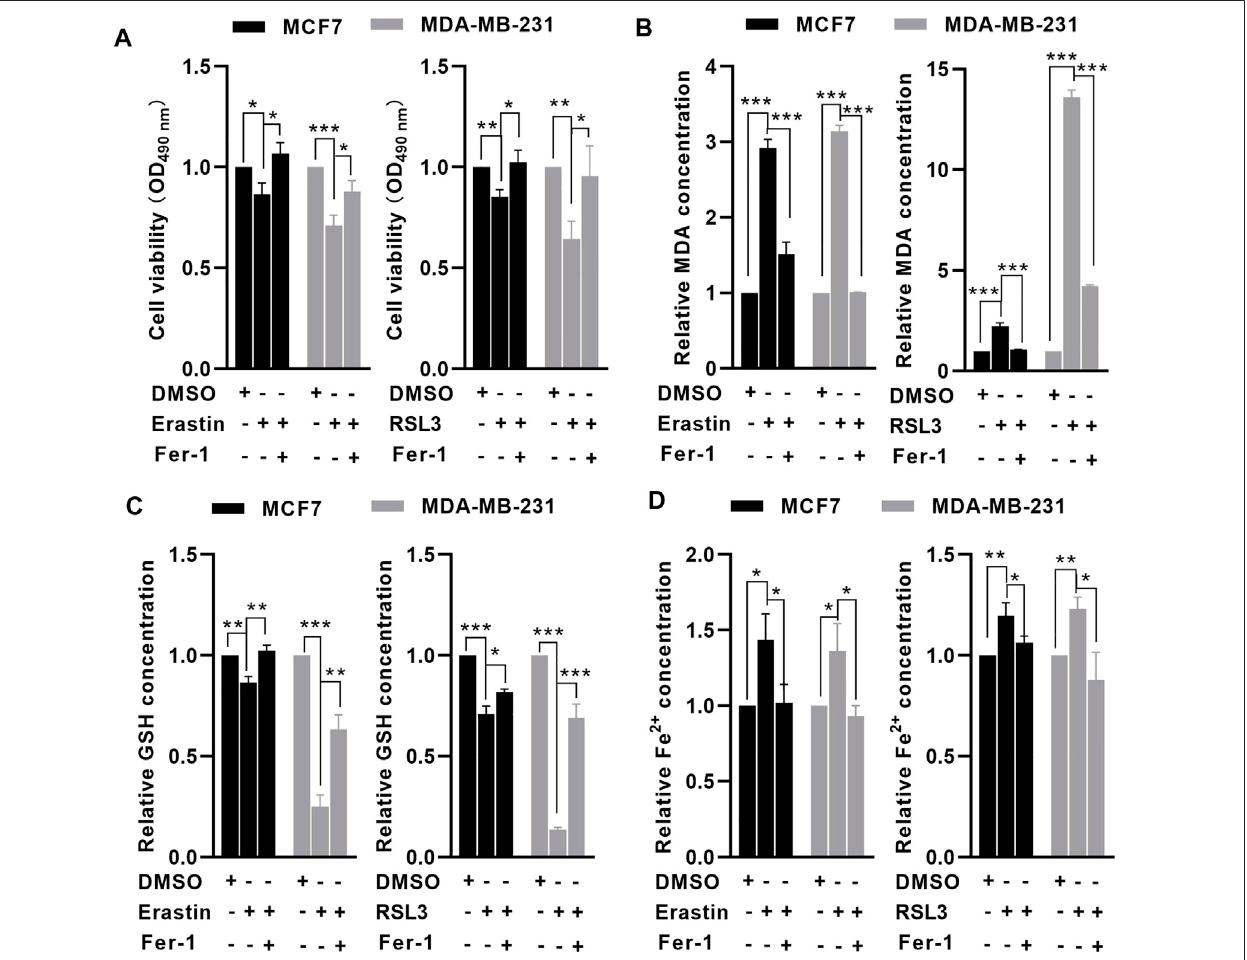
FIGURE 1 | MCF7 and MDA-MB-231 cells were sensitive to erastin- and RSL3-induced ferroptosis. MCF7 and MDA-MB-231 cells were preincubated with or without 1 μ M Fer-1 for 1 h. After that, the cells were treated with erastin (10 μ M) or RSL3 (1 μ M) for 24 h. MTT assay showed that erastin or RSL3 signi fi cantly reduced MCF7andMDA-MB-231cellviability. (A) ErastinorRSL3reducedGSH (B) levelsbutincreasedintracellularMDA (C) andfreeiron (D) levelsinMCF7andMDA-MB-231 cells ( n = 3 independent repeats). * p < 0.05; ** p < 0.01; *** p <